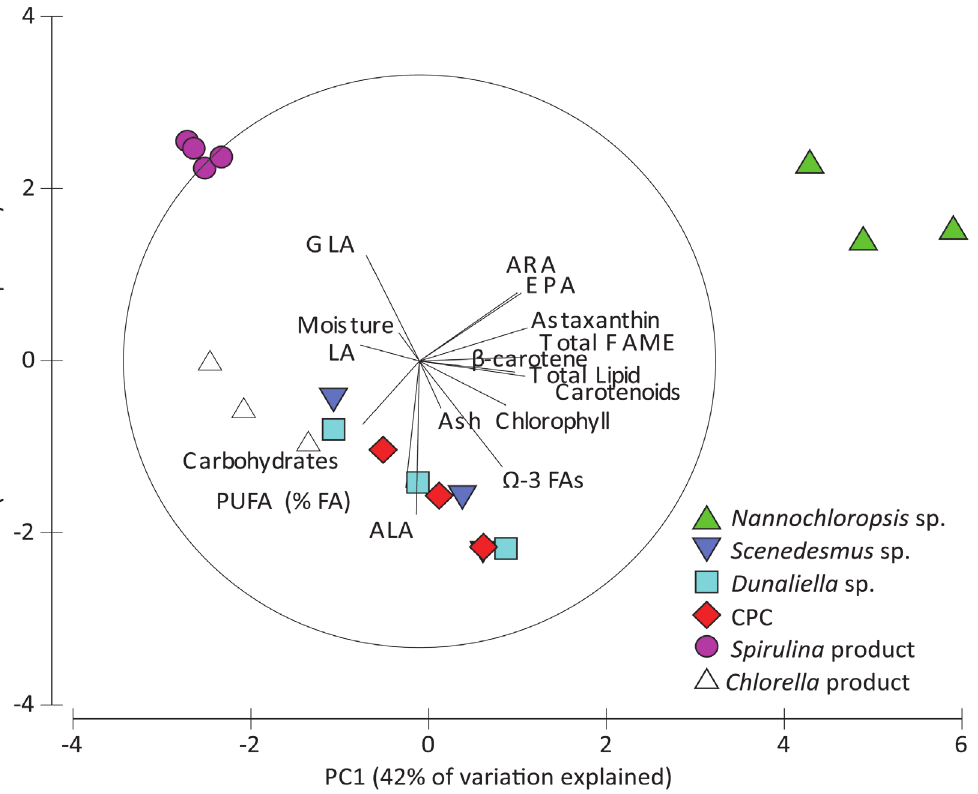
Fig 1. Principal component analysis (PCA) depicting extent of differences in biochemical parameters between James Cook University/MBD Energy (JCU/MBD) microalgae ( Nannochloropsis sp., Dunaliella sp., Scenedesmus sp., and the CPC) and commercial microalgae products, which are indicated by the length of radiating lines. Biochemical parameters corresponding to the radiating lines pointing towards species indicate parameters of similarity, while opposite radiating lines indicate dissimilarity.